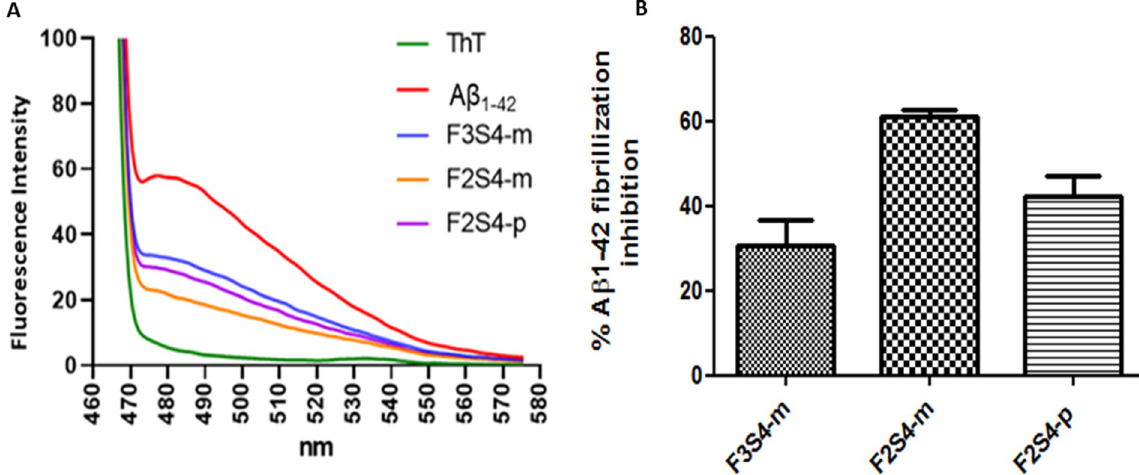
Fig 4. Percentage of inhibition of A β 1–42 fibrillation. A) ThT assay using compounds F2S4-m , F2S4-p, and F3S4-m at 100 μ M B) Plot of percentage of inhibition of A β 1–42 fibrillation by the compounds.